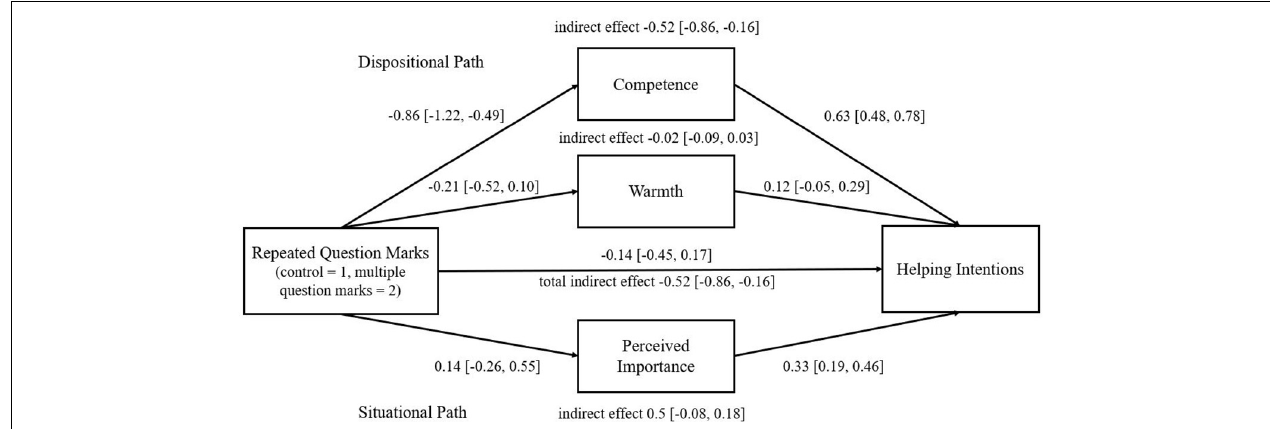
FIGURE 1 | Experiment 1 multiple-mediation model of the effect of use of repeated question marks (vs. one question mark) on helping intentions. N = 142; beta coefficients and confidence intervals are presented based on PROCESS Model 4 (Hayes and Preacher, 2013), controlling for writer’s gender. Overall model— F (5,136) = 46.08, R 2 = 0.63 ( R 2 med = 0.42—explained variance of the mediation is calculated based on Fairchild and MacKinnon, 2009). • Repeated question marks—the manipulation of number of repeated question marks